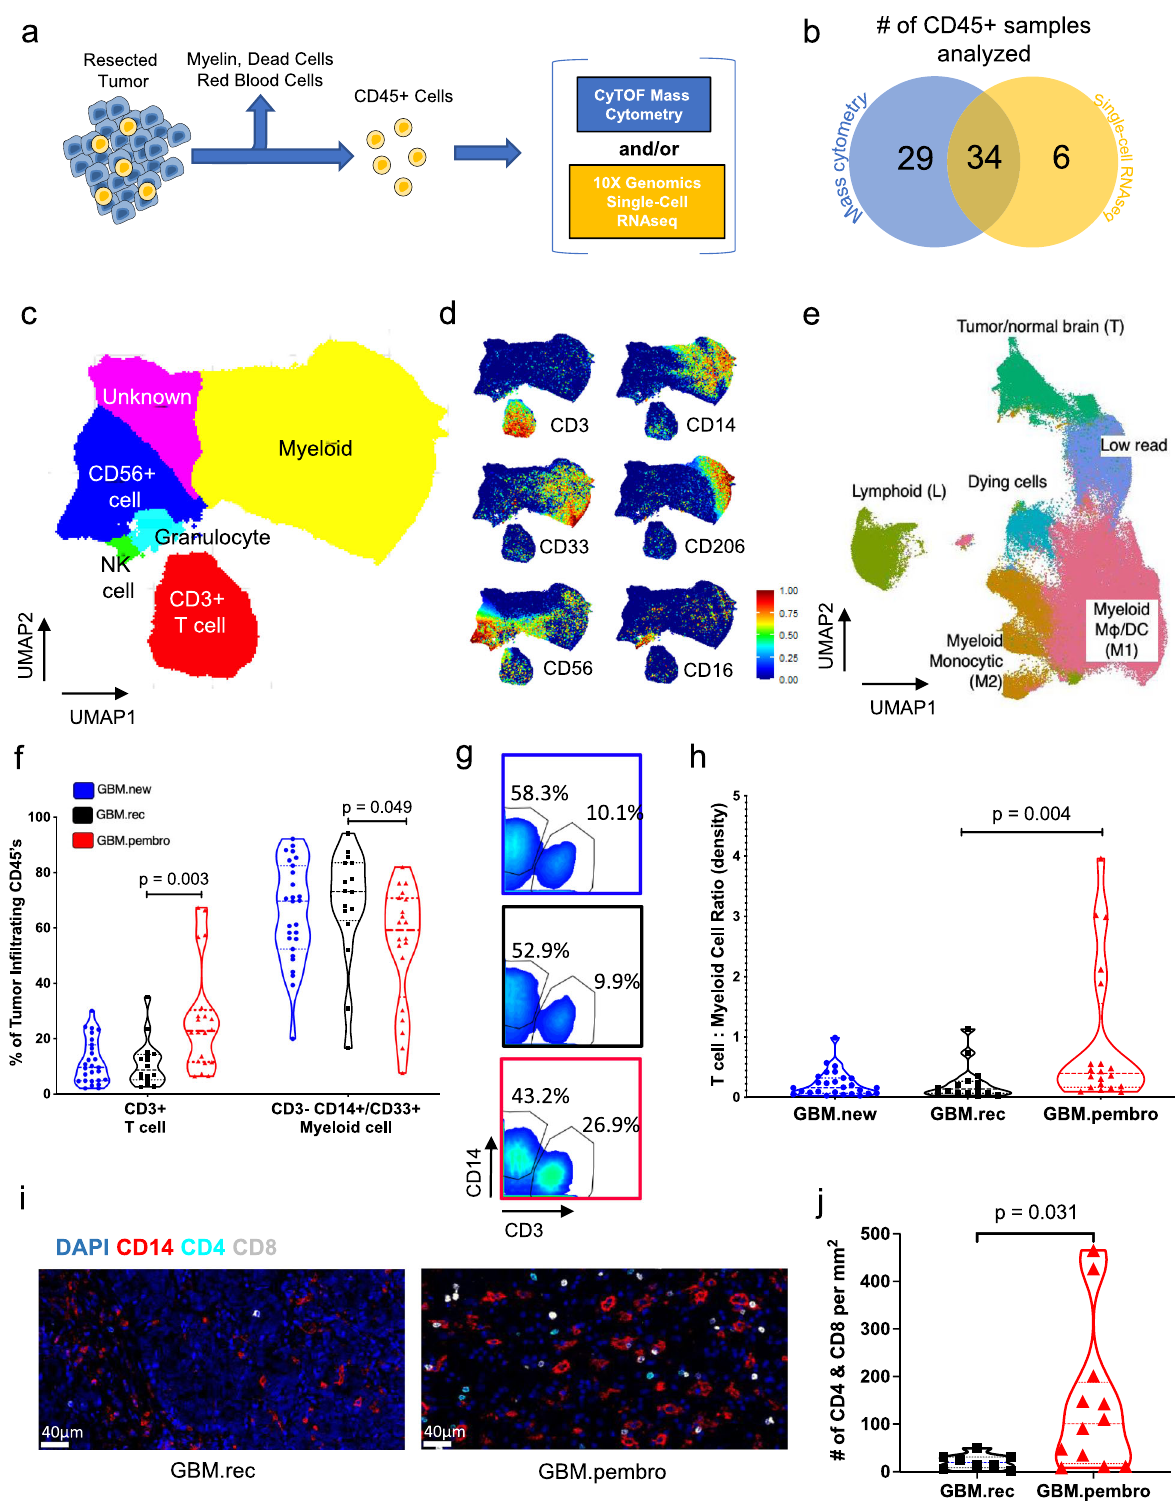
Neo-aPD1 therapy increases the overall T cell in fi ltrate in the GBM microenvironment . We began our analysis looking at the overall changes to the tumor-in fi ltrating T cell and myeloid cell compartments after neo-aPD1. Our CyTOF analysis showed a signi fi cant increase in the proportion of CD3 + T cells in the tumor-in fi ltrating immune populations in the GBM.pembro group and a corresponding decrease in the